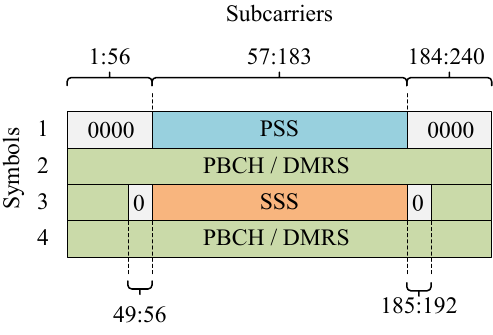
Fig. 1 . Structure of